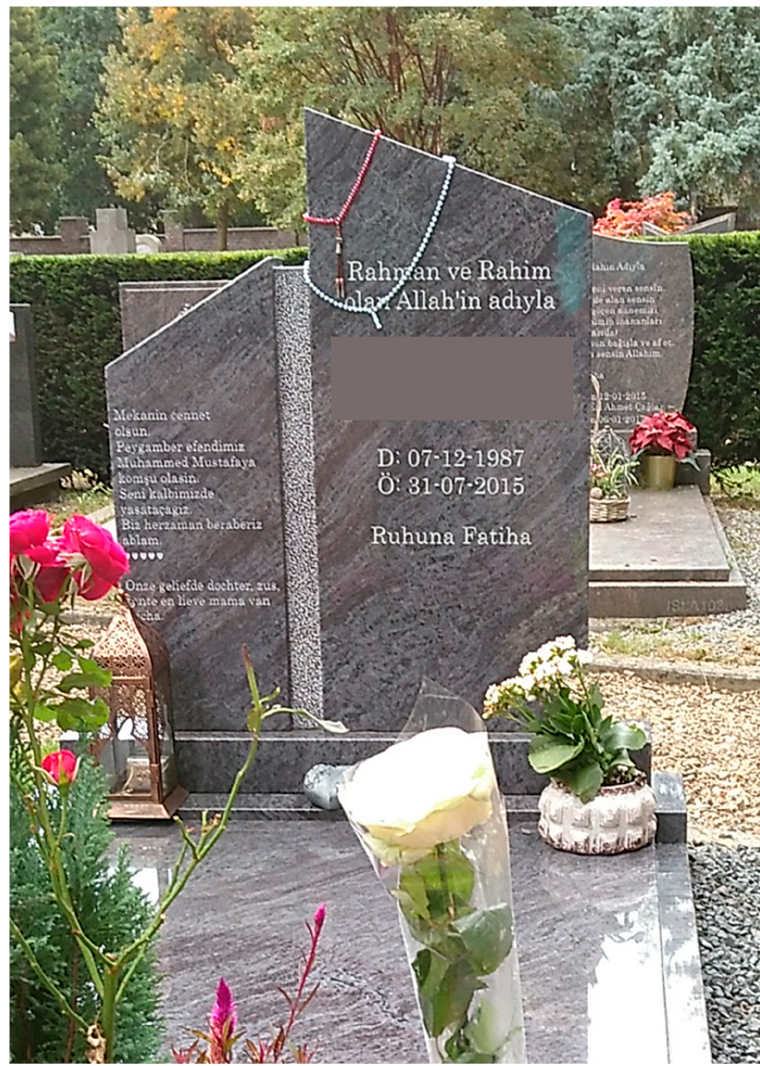
Figure 7. A recent Islamic grave situated in the Islamic section (photograph: